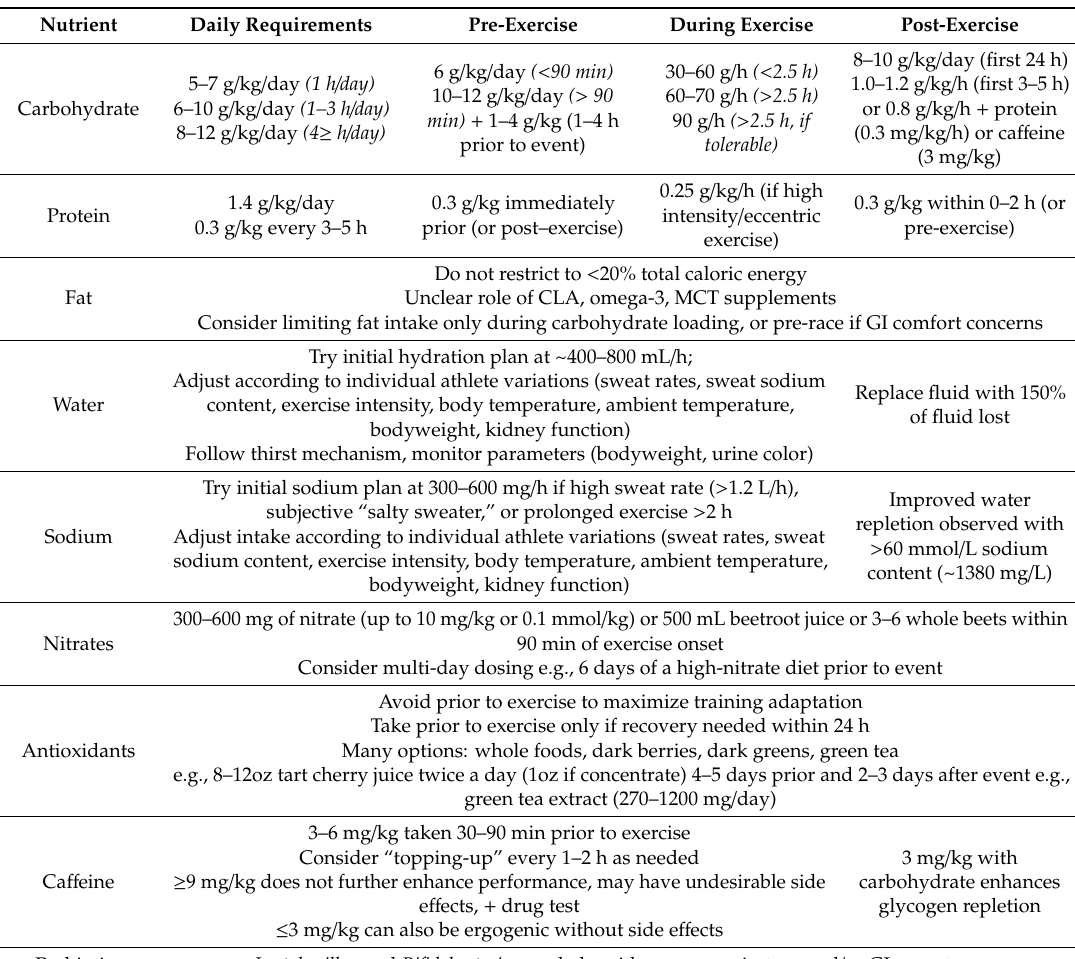
Table 1. Key recommendations for macronutrients, hydration, and supplements (exercise duration is listed in italics within